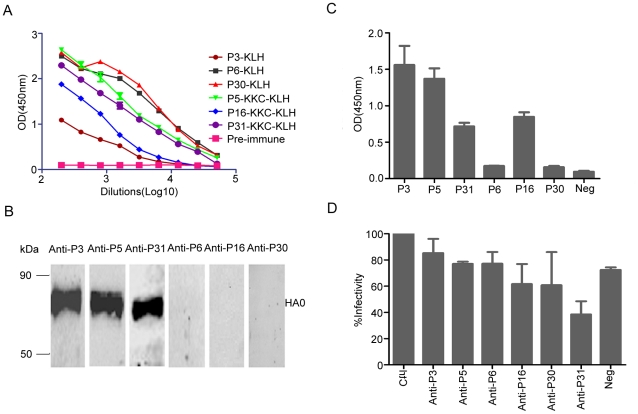
Immunogenicity of immunodominant peptides.(A) Titration of IgG antibody against peptides derived from the H1N1pdm virus. The titers of murine sera were determined as a series of two-fold dilutions by ELISA. (B and C) The reactivities of anti-peptide sera (1∶400 dilution) with the purified HA0 protein of the H1N1pdm virus were analyzed by Western blot (B) and ELISA (C). For the ELISA assay, the OD450 nm values are expressed as mean ± SD. (D) Neutralization activity of anti-peptide sera. HA-pseudotype neutralization tests were performed to determine the neutralizing activity of the anti-sera derived from immunization with the peptides P3, P5, P6, P16, P30, and P31 in mice. The percentage of infectivity compared to that of negative serum (Ctrl) was calculated. Serum that induced a 90% reduction of infectivity was considered positive. Data were from at least duplicate testing of serum samples.